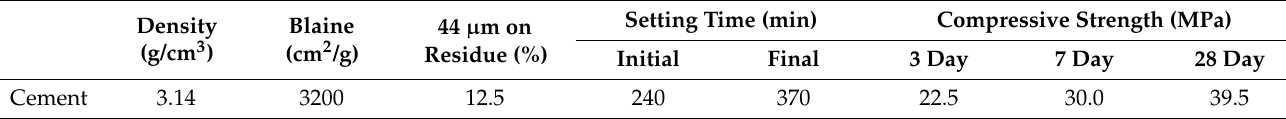
Table 4. Physical properties of the cement used in this study.